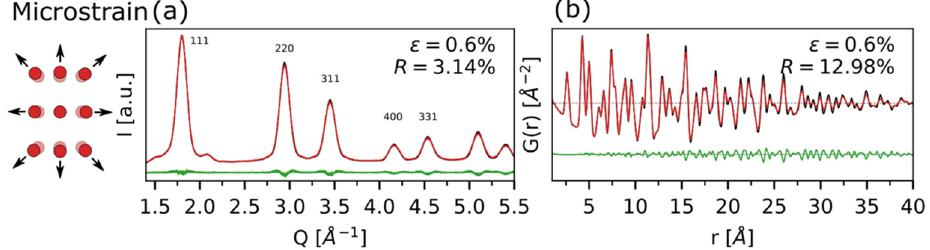
Figure 7. Isotropic microstrain effect, with ε = 0.6%, particularly effective on the peaks broadening in the high- Q region for the DSE simulation ( a ), and in the dampening of G ( r ) with r ( b ). The unstrained simulations (black lines) and the corresponding R -values are reported for comparison.